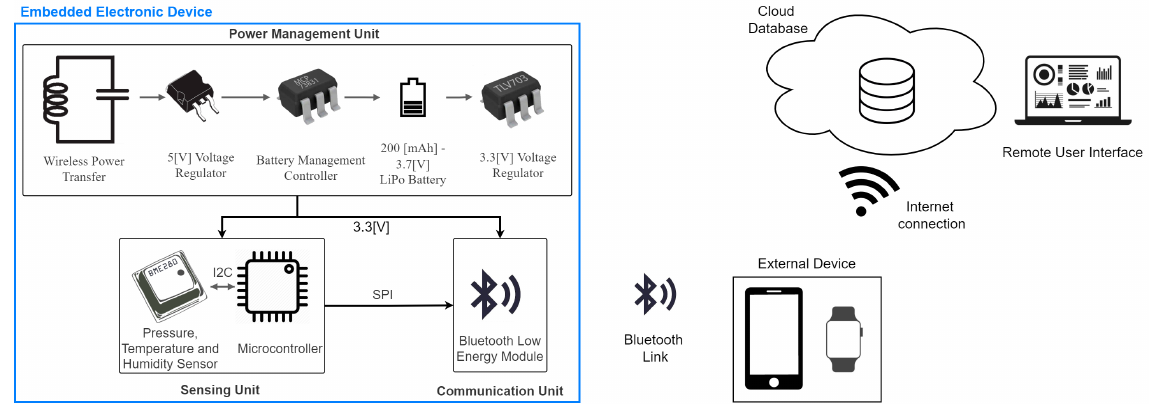
Figure 1. Hardware diagram of the proposed system using the embedded electronic